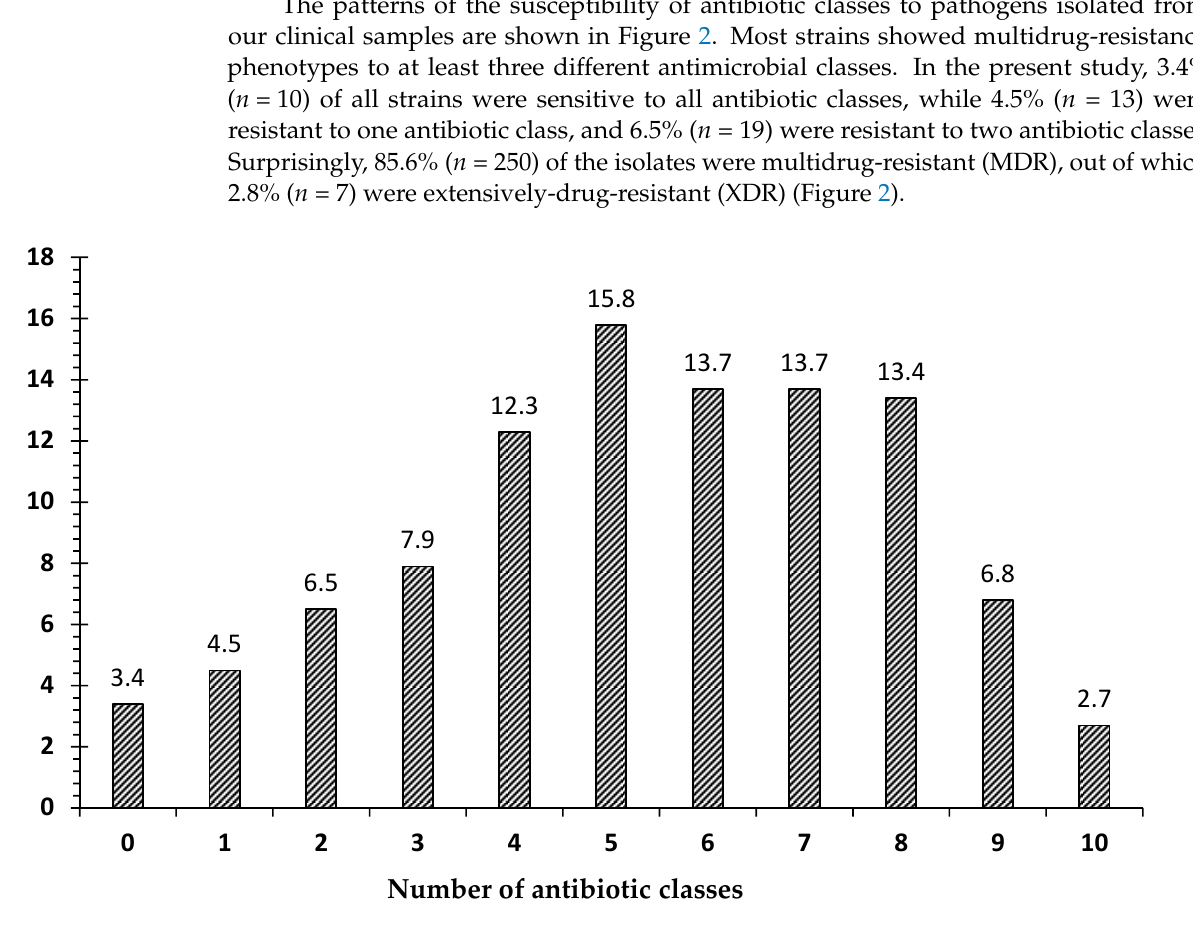
Figure 2. The percentage of strains resistant to antimicrobial agents from 11 antibiotic classes of the 292 bacterial strains obtained from clinical specimens: 0 means not resistant to any antibiotic group (sensitive to all groups); 1–10 indicate the numbers of classes to which the bacterial strains showed resistance; 1 indicates the percentage of strains that were resistant to only one class of antibiotic; 2 indicates the percentage of strains that were resistant to two classes of antibiotics, etc.